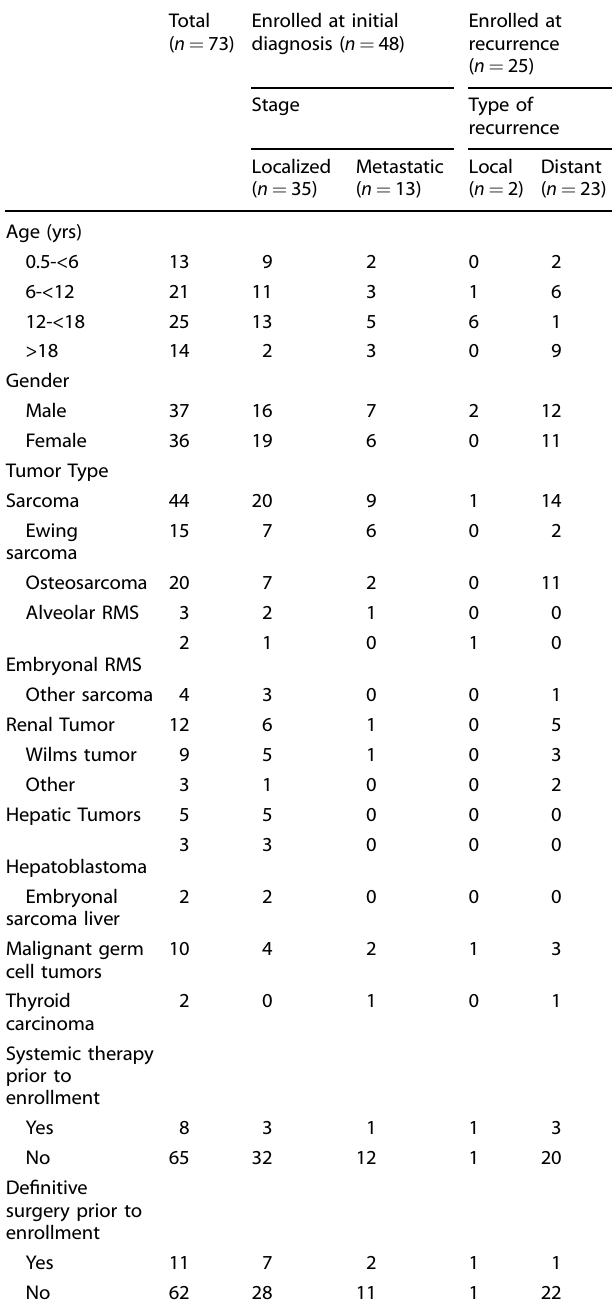
Table 1. Patient